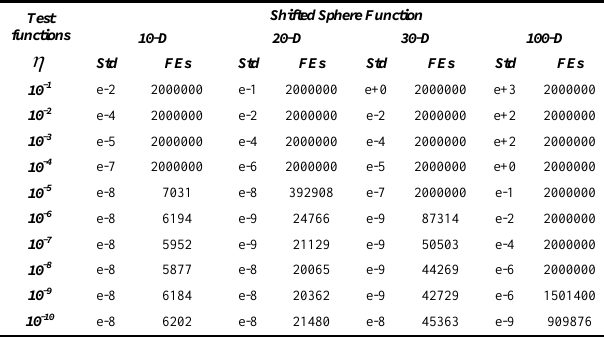
Table. 3 The result of benchmark testing on Shifted Sphere Function with different values of  Test